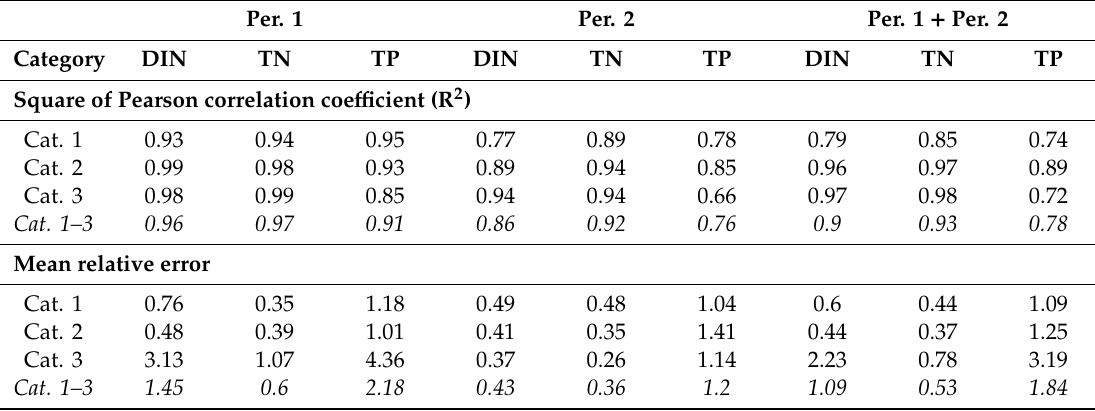
Table 7. Validation results of all compounds for the two periods. Per. 1 Per. 2